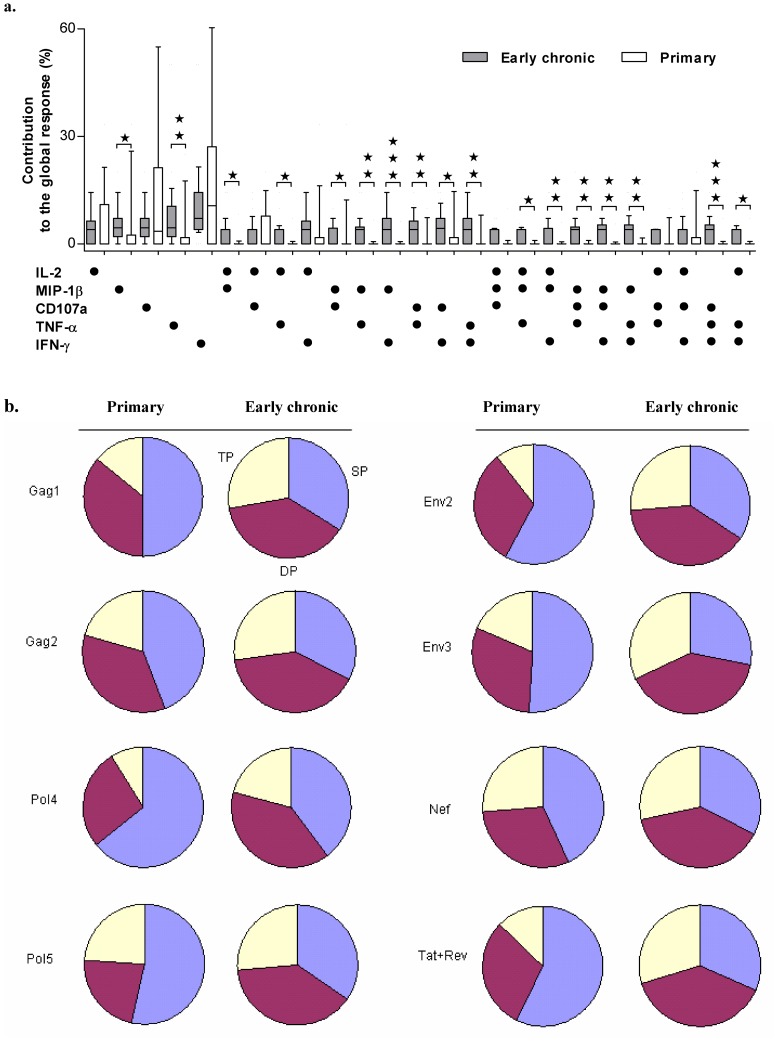
Comparison of the weighted contribution of different functional CD8+ T-cell subsets to the global HIV peptide pool-specific CD8+T-cell responses between primary and early chronic HIV-1 infection groups.a. Detailed weighted contribution of different functional CD8+T subsets to the global CD8+ T response against HIV-Pol5 peptide pool. HIV-specific CD8+ T cells from early chronic infections have a qualitatively different functional profile compared to primary infections. The box plots represent the 10th, 25th, 75th, and 90th percentiles of the proportion of the respective functional responses toward the total CD8+ T-cell responses. Asterisks were placed above response pairs that were significantly different: ***p<0.001; **p<0.01 and *p<0.05. Each dot denoted a positive response for the function indicated at the bottom left. b. Proportions of triple producers (TP), double producers (DP) and single producers (SP) of CD8+ T cells responding to eight peptide pools during primary and early chronic HIV-1 infections, were shown in the pie charts, respectively.